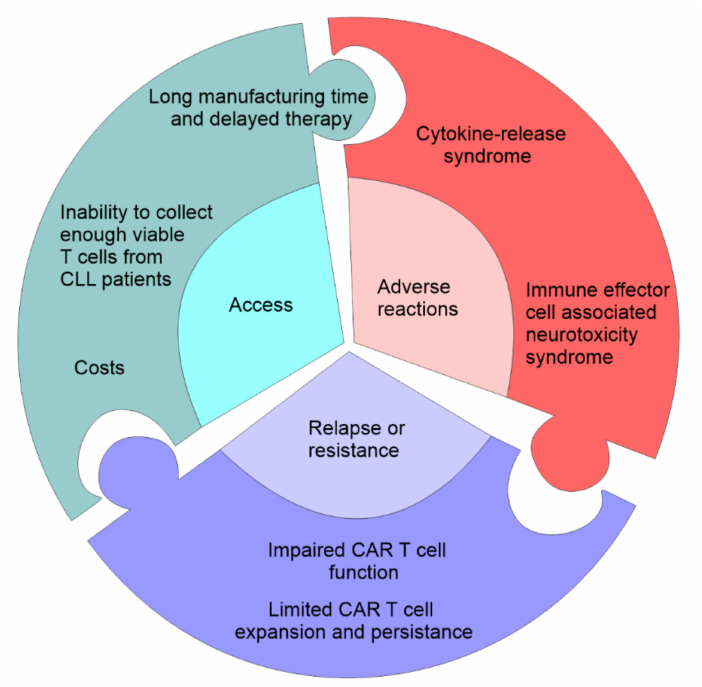
Figure 2. Challenges in CAR T-cell therapy. The first problem associated with CAR T cell therapy is access which can be limited by the cost of the manufacture of CAR T cells, time needed to manufacture and expand CAR T cells, failure to produce autologous CAR T cells, and eligibility for the clinical trial. The second problem associated with CAR T cell therapy are serious adverse event: cytokine-release storm (widespread pyroptosis of tumor cells is followed by the release of different factors that activate macrophages to produce inflammatory cytokines that induce systemic inflammatory response), and neurotoxicity syndrome (toxic encephalopathy caused by the disruption of the blood-brain-barrier). CAR T cell therapy may be accompanied by the primary resistance due to the impaired CAR T cell function and the inability to induce remission and limited CAR T cell